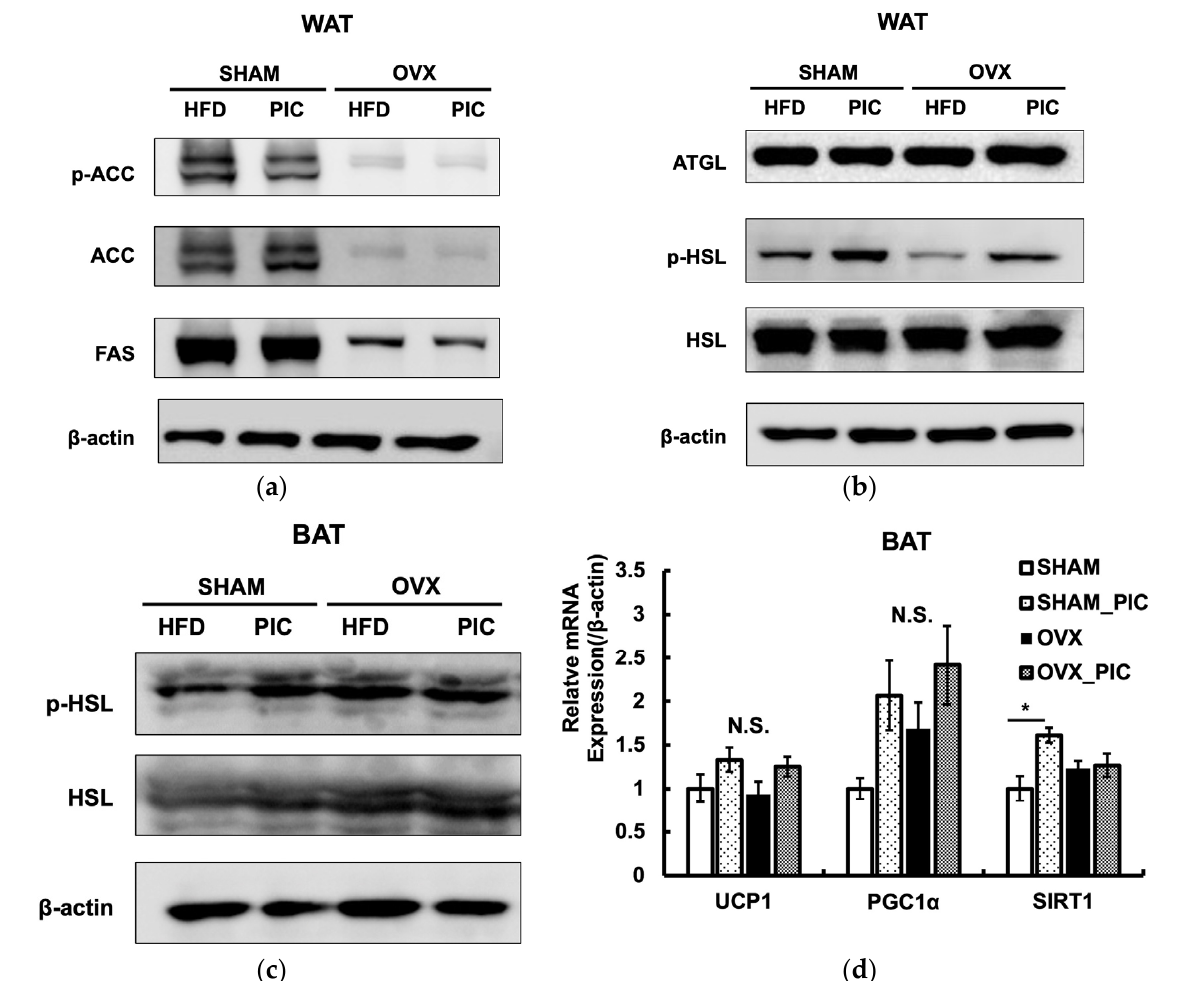
Figure 4. Effects of piceatannol on the expression of proteins and mRNA. ( a ) Adipogenesis-related proteins and ( b ) lipolytic proteins in WAT. ( c ) Phospho-HSL in BAT. The western blotting is representative of at least four independent experiments. ( d ) mRNA expression in BAT. Data are expressed as the means ± SE ( n = 5–6 per group). Asterisk denotes significant difference ( p < 0.05) as determined by Tukey–Kramer’s test and N.S. denotes not significant. The experiments were repeated three times, and the results were found to be reproducible.